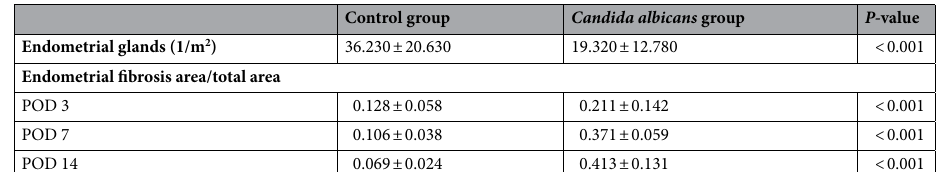
Table 3. Ratio of endometrial fibrosis area to total area and endometrial gland density in the control and Candida albicans groups. Unless indicated otherwise, data are given as the mean ± SD. POD postoperative day.